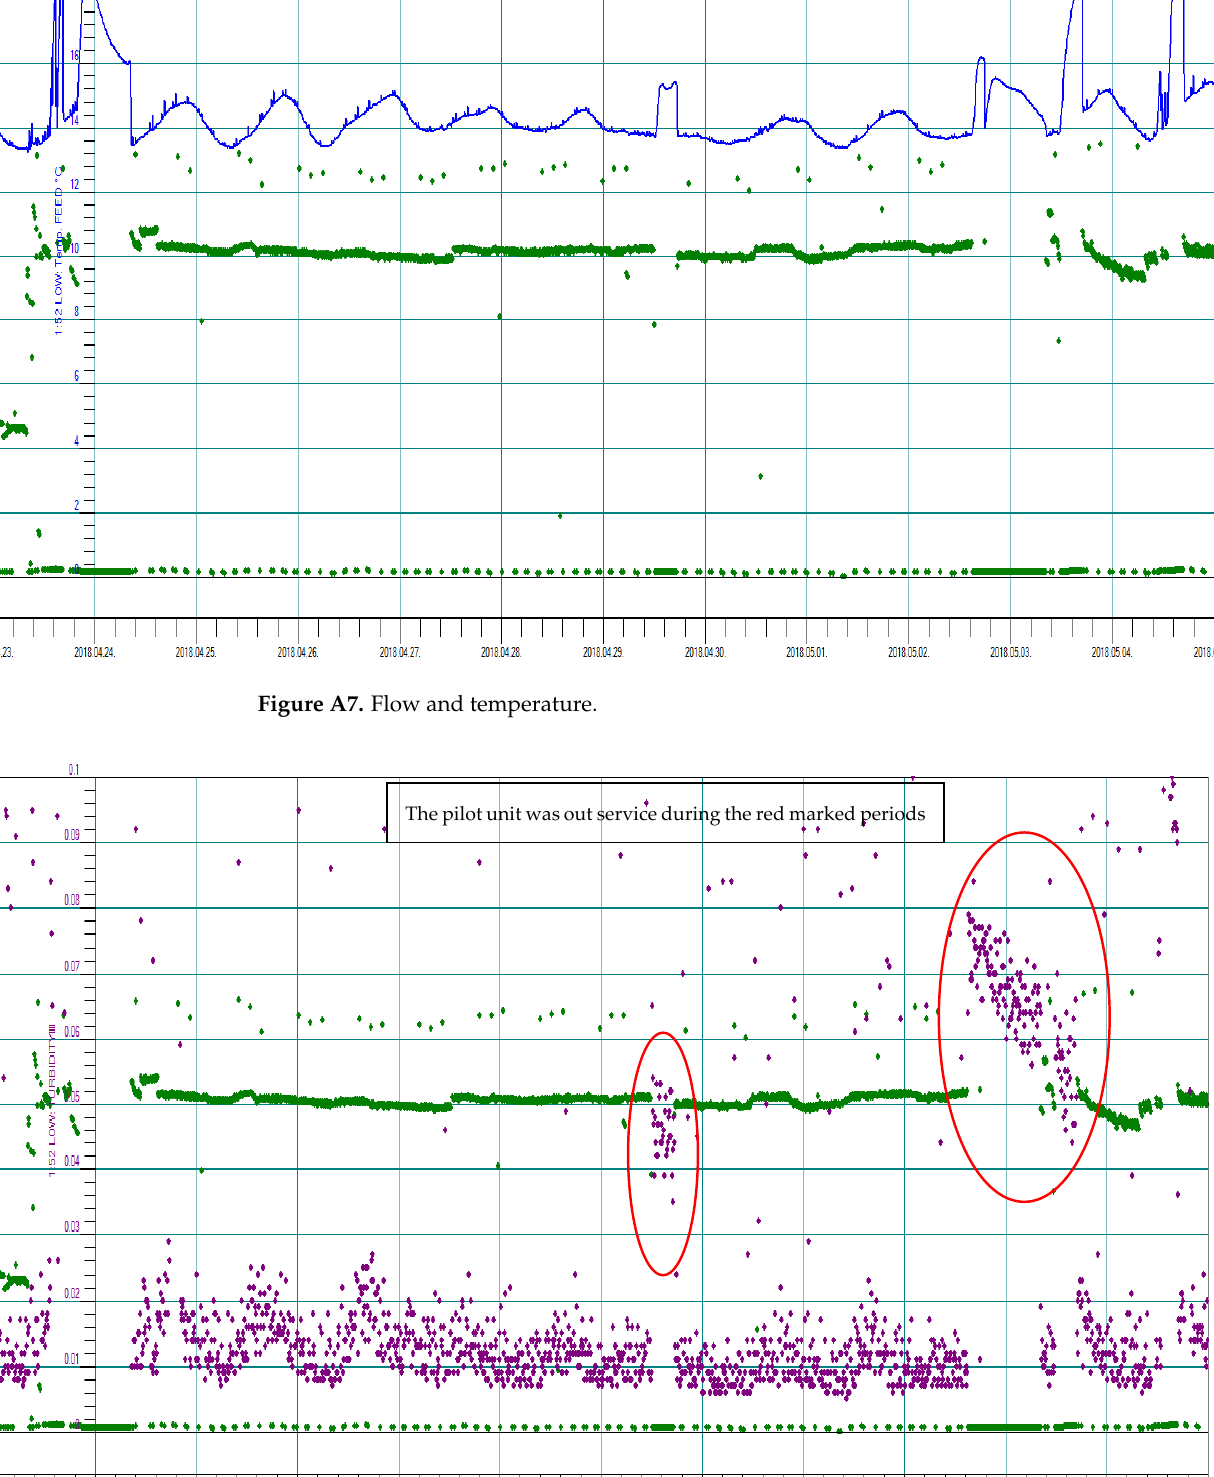
Figure A8. Flow and permeate turbidity.